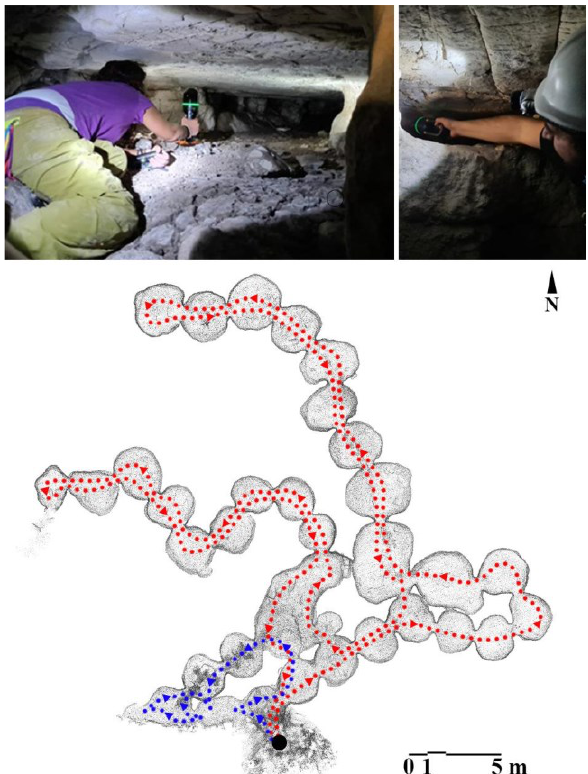
Figure 3 . On site acquisition by P30-BLK360 LS and top view of the final laser scanner point cloud.